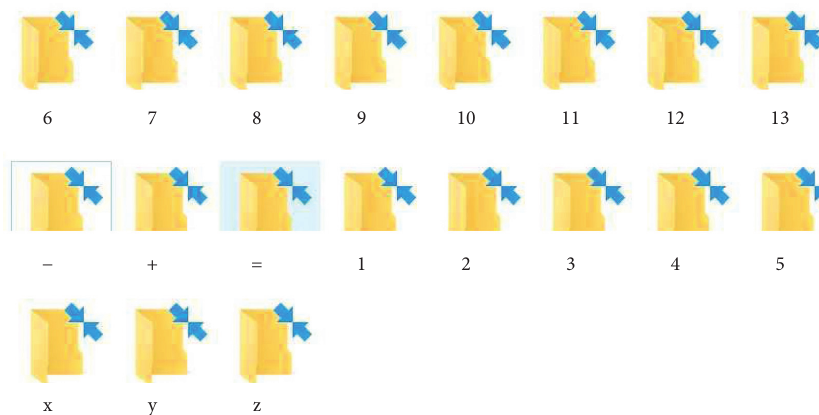
Figure 14: An example of character dataset.